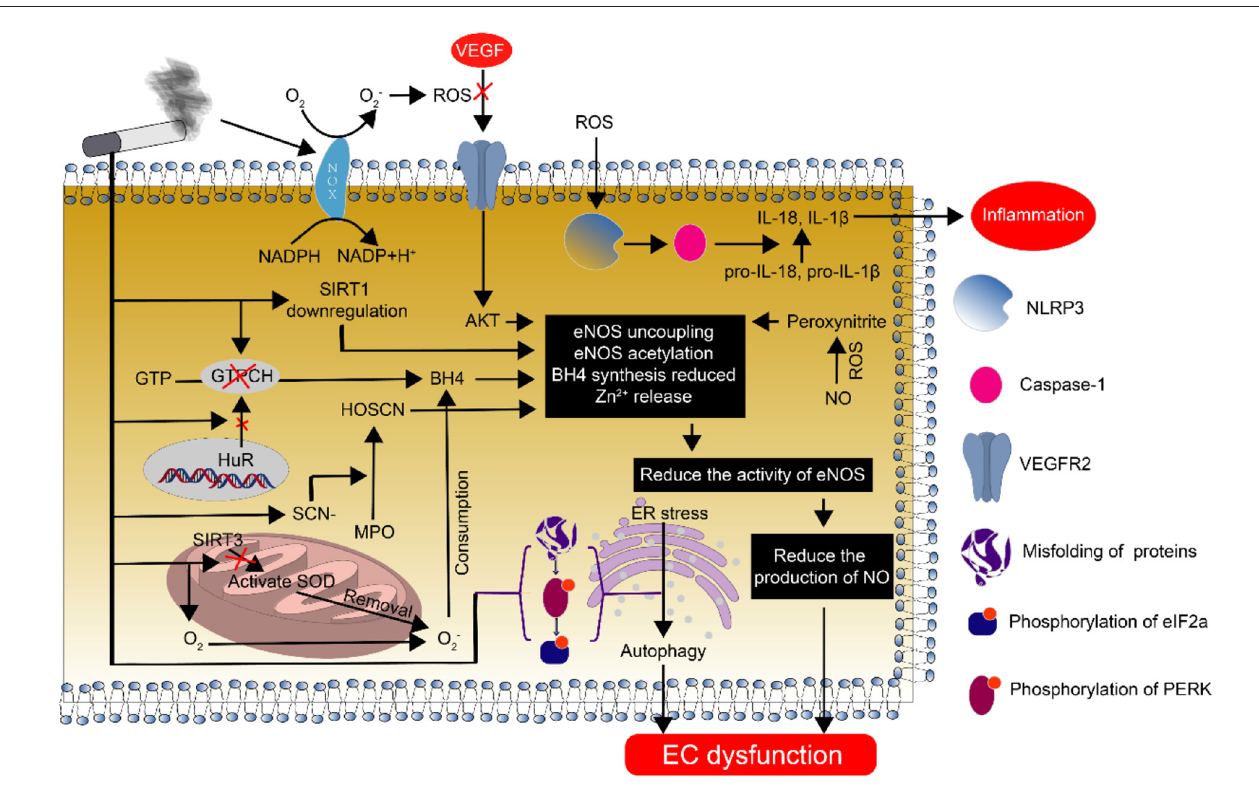
FIGURE 3 | Endothelial cell dysfunction caused by smoking and its mechanism. Smoking causes endothelial cell dysfunction through various pathways. The most important pathway is the decrease in NO synthesis due to eNOS deficiency and the reduction in eNOS function, which plays an important regulatory role in endothelial dysfunction.